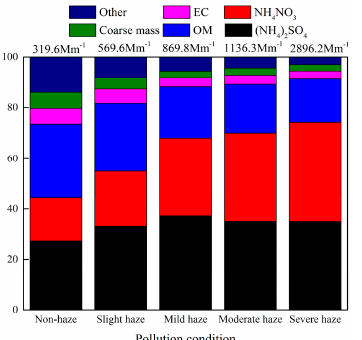
Figure 7. Variations of the contributions of different components to the light extinction under different haze pollution levels.